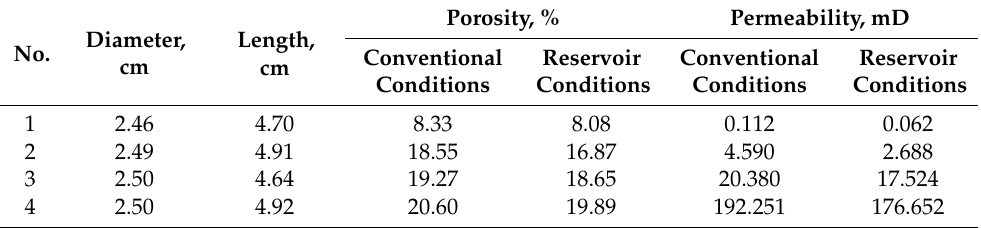
Table 1. Basic parameter of rocks.